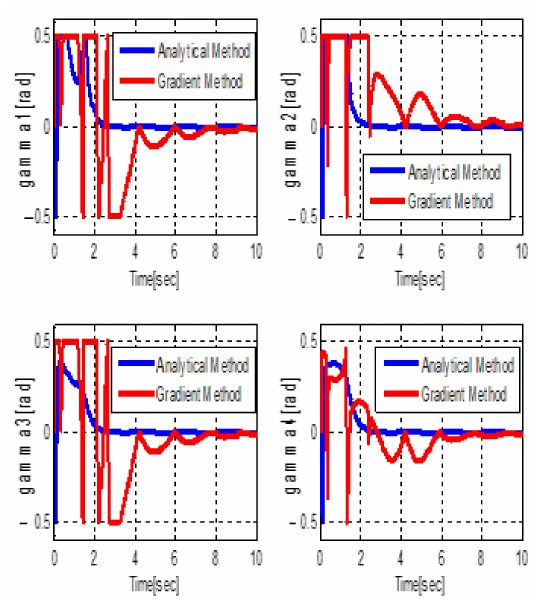
Figure 9. Thrust forces of the propellers.